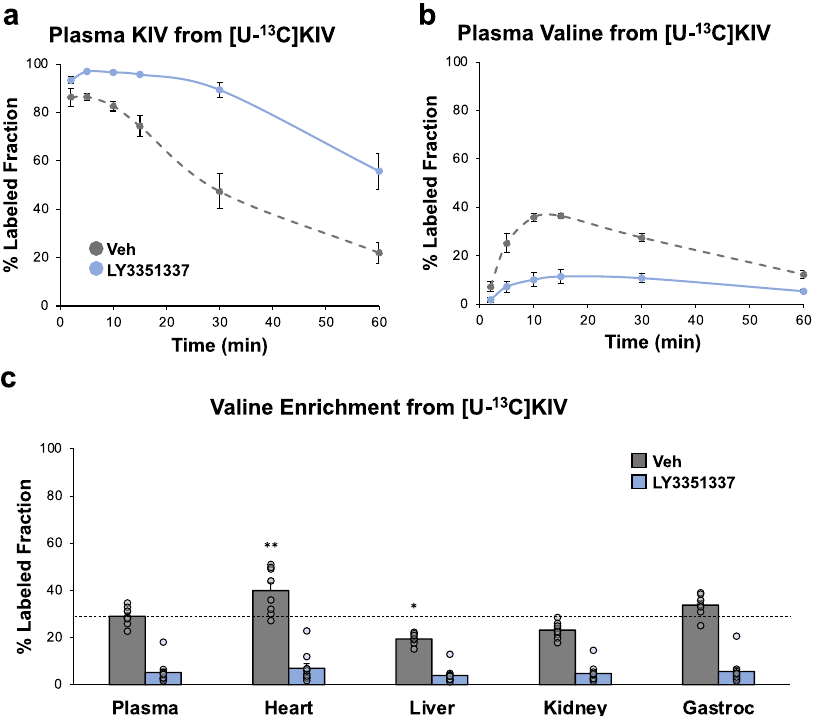
Fig. 2 KIV reamination across tissues in living rats. Thirty minutes after a single injection of BCAT inhibitor, LY3351337 (10 mg/kg i.p.; n = 5; blue), or Veh (DMSO; n = 5; gray), Wistar rats received an i.p. injection of [U- 13 C]KIV (100 mg/kg), followed by blood sampling from the tail vein at 2, 5, 10, 15, 30, and 60 min. Fractional percent labeling with 13 C of ( a ) plasma KIV and ( b ) plasma valine. N = 5 – 6 per group. A separate cohort of Wistar rats was treated with LY3351337 (10 mg/kg i.p.) or vehicle and received an i.p. injection of [U- 13 C]KIV (100 mg/kg) 30 min later. Tissues were harvested 30 min after the [U- 13 C]KIV injection. c Fractional percent labeling with 13 C of valine in plasma and the indicated tissues in the absence (Veh; n = 8) or presence of LY3351337 ( n = 10). The dashed line indicates the plasma enrichment level. Data represent mean ± SEM. Statistical differences indicated by a two-way paired Student ’ s t -test: * P < 0.05, ** P <